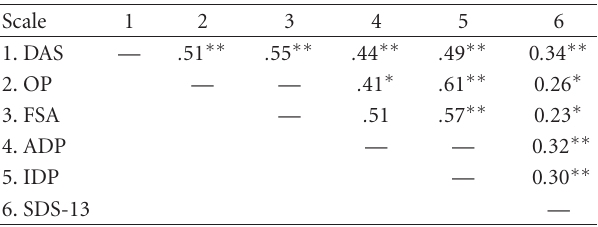
Table 3: Intercorrelations between the DAS, OP, FSA, ADP, IDP, and SDS-13.